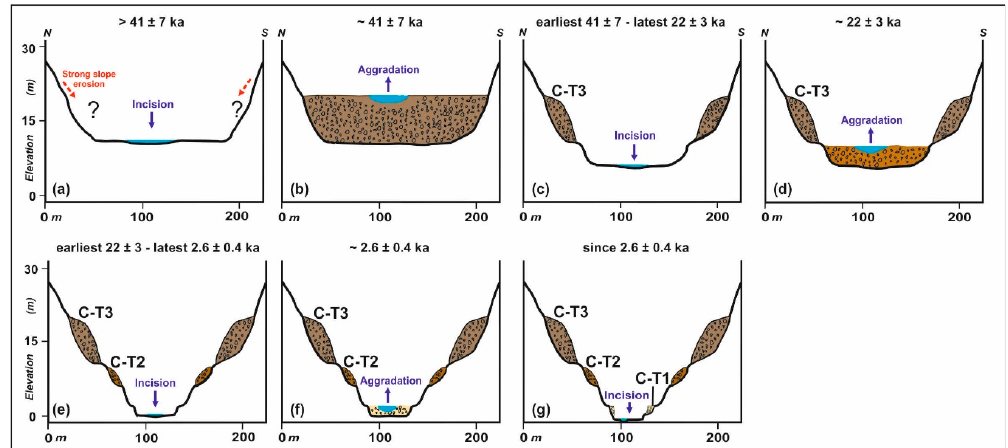
Figure 8. Schematic model of the landscape evolution at the studied site at the main eastern river in the lower catchment since ca. 41 ka (location in the river system please see Figure 3). ( a ) > 41 ± 7 ka, ( f ) ≈ 2.6 ± 0.4 ka, ( g ) since 2.6 ± 0.4 ka. Please note that the aggradation periods can have lasted longer than the respective luminescence ages with their error ranges.